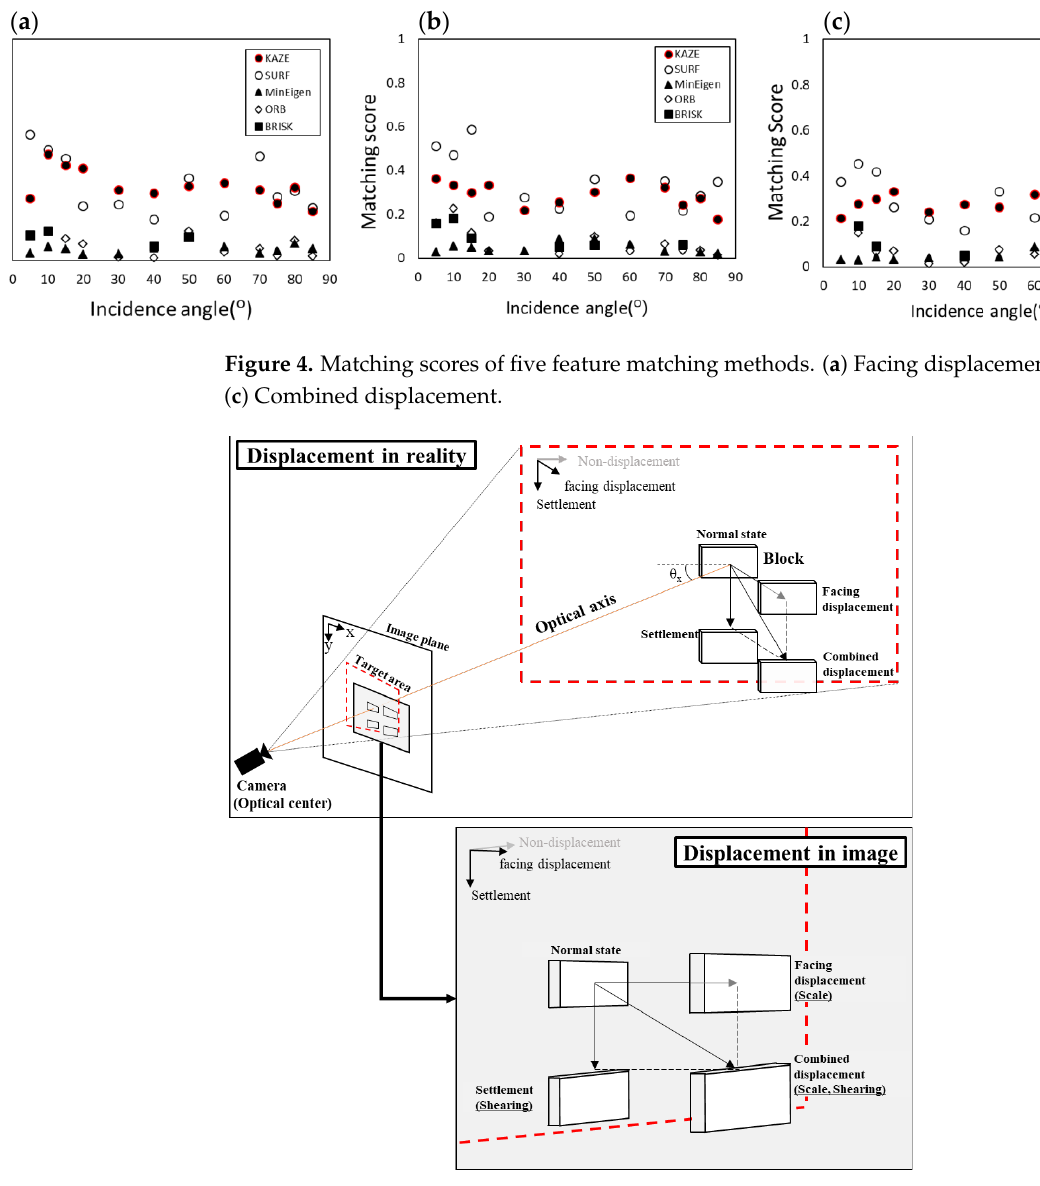
Figure 5. Block shape in reality and in the image according to the occurrence of three types of behaviors.